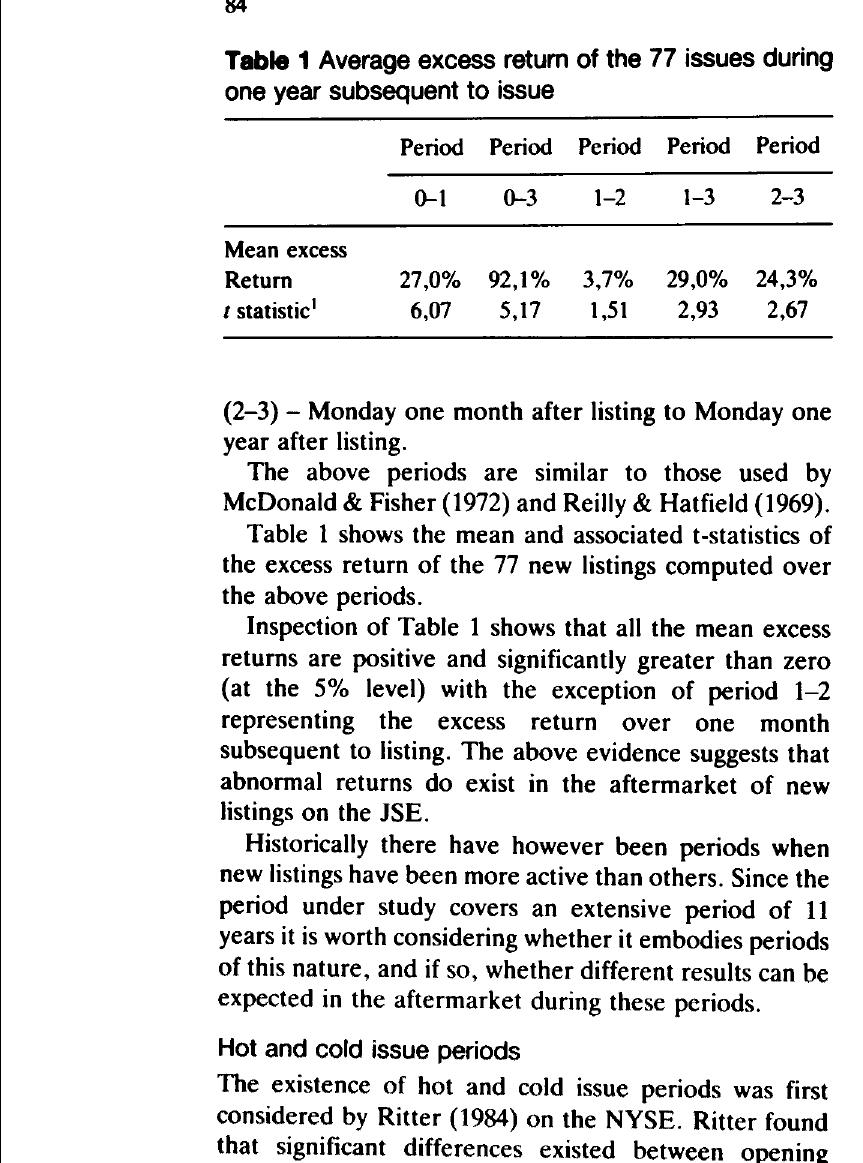
Figure 1 Average excess returns for hot periods